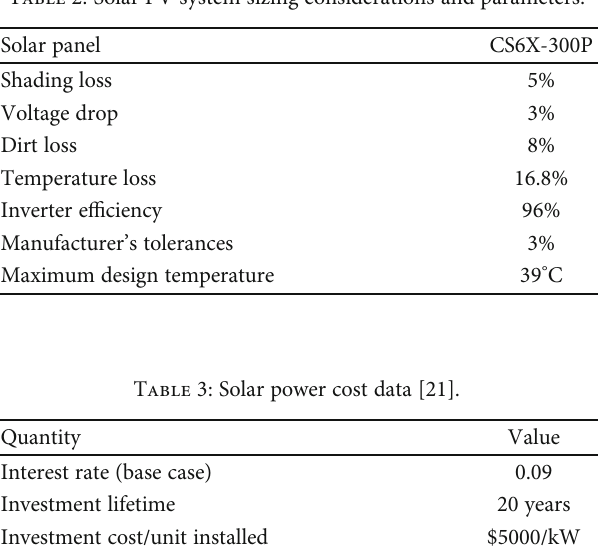
Table 2: Solar PV system sizing considerations and parameters.